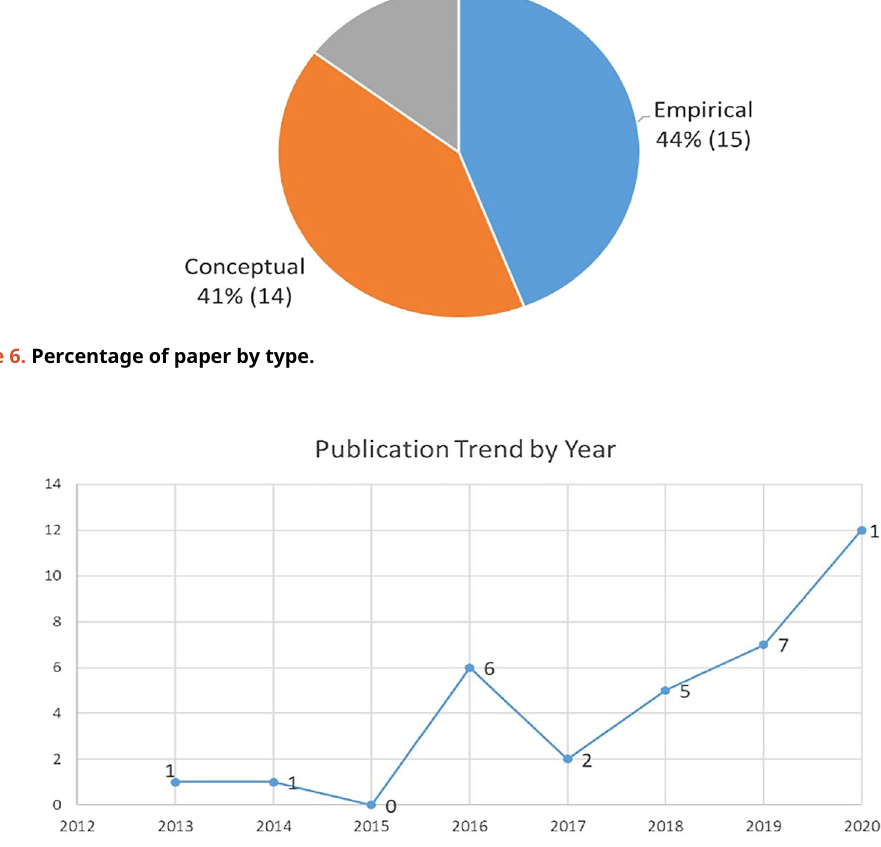
Figure 7. Publication trend by year.